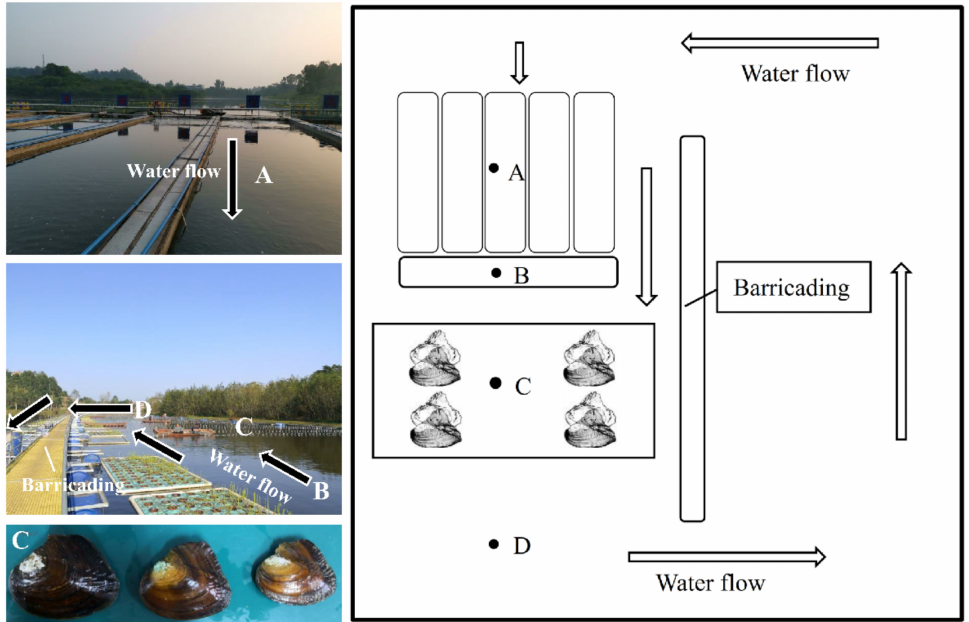
Figure 1. Schematic diagram of pond aquaculture structure and Hyriopsis cumingii area selection (( A ) Fish intensive culture area, ( B ) Tailwater discharge area, ( C ) H. cumimgii purification area, ( D ) Ecological purification